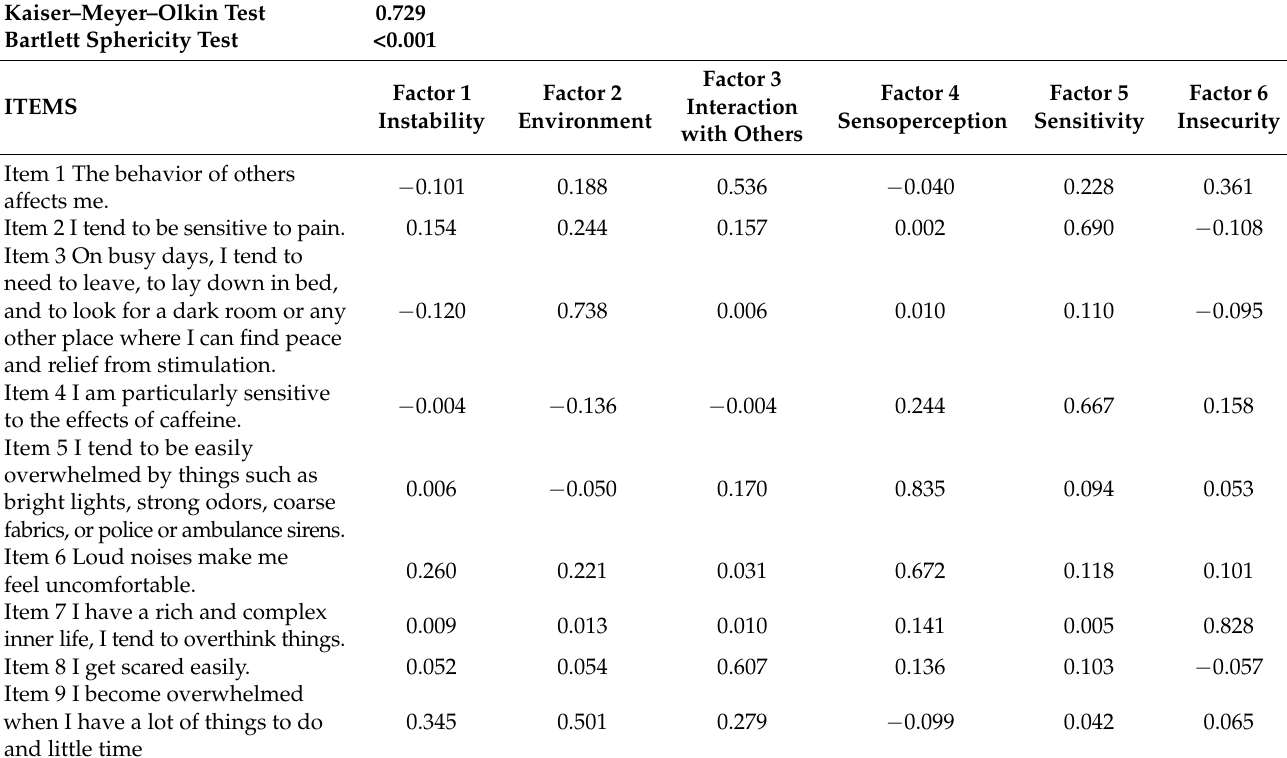
Table 4. Factor loading of the questionnaire items. Rotated components